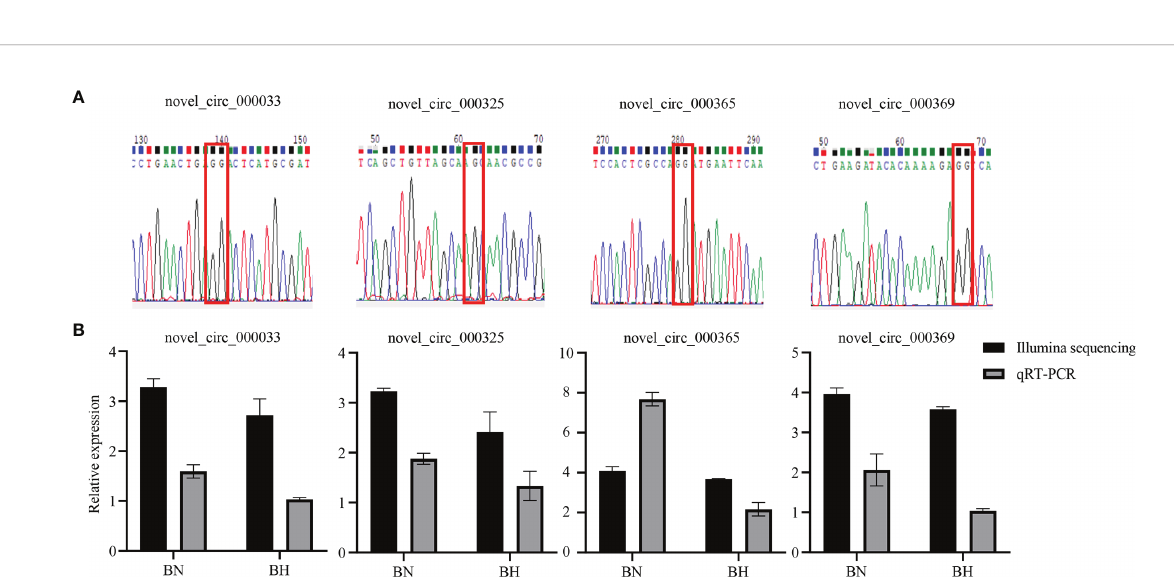
“ L-phenylalanine aminotransferase activity ” may be of biological signi fi cance. KEGG pathway analysis identi fi ed seven signi fi cantly enriched pathways, of which “ glycosphingolipid biosynthesis-globo and isoglobo series ” was the most involved ( Figure 5B and Supplementary Table S7 ).